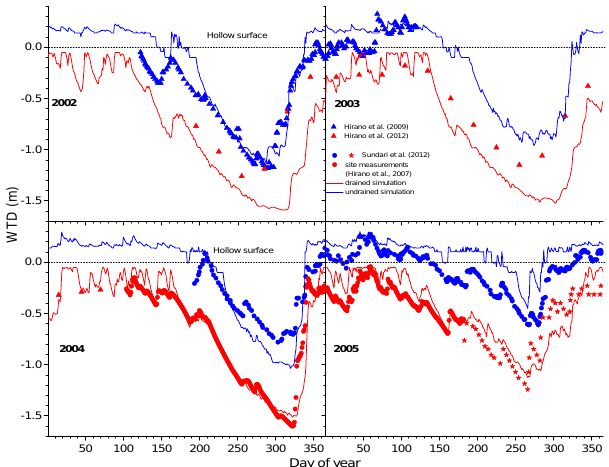
Fig. 9. Simulated daily drained vs. undrained water table depths (WTD) (Sect. 2.2.6) during 2002–2005 over a drainage affected tropical peat swamp forest at Palangkaraya, Indonesia. Drained WTDs are the same as those in Figs. 2c, 3c, 4c and 5c for 2002, 2003, 2004 and 2005 respectively. Negative values of WTD mean depths below the hollow surface and positive values mean depths above the hollow surface.